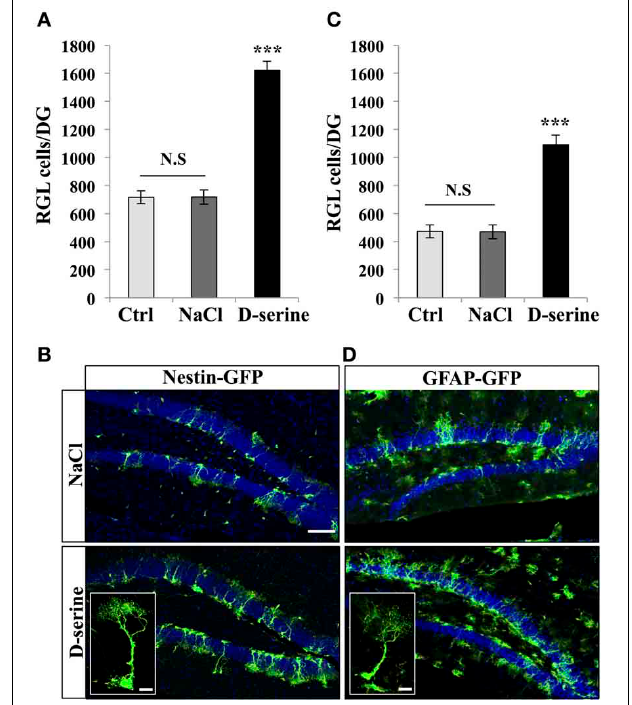
FIGURE 2 | D-serine increased the number of RGL cells. (A) Histogram showing the number of RGL cells per dentate gyrus of nestin-GFP mice injected with D-serine, NaCl or not injected (Ctrl). Animals n = 4 per group. (B) Confocal maximal projection micrographs of hippocampal sections in the two injected groups (D-serine and NaCl). Inset: higher magnification confocal micrograph of a RGL cell. (C) Histograms showing the number of RGL cells in the dentate gyrus of GFAP-GFP mice injected with D-serine, NaCl and in control, non-injected animals (Ctrl). Animals: n = 4 animals per groups. (D) Confocal maximal projection micrographs of hippocampal sections from the two experimental groups. Inset: higher magnification micrograph of a RGL cell. Blue: Dapi staining. Each value represents the mean ± SEM; post-hoc bilateral Student’s t -test, ( ∗∗∗ p < 0 . 001), N.S., non-significant ( p > 0 . 05). Scale bar: 100 μ m. Insets 10 μ